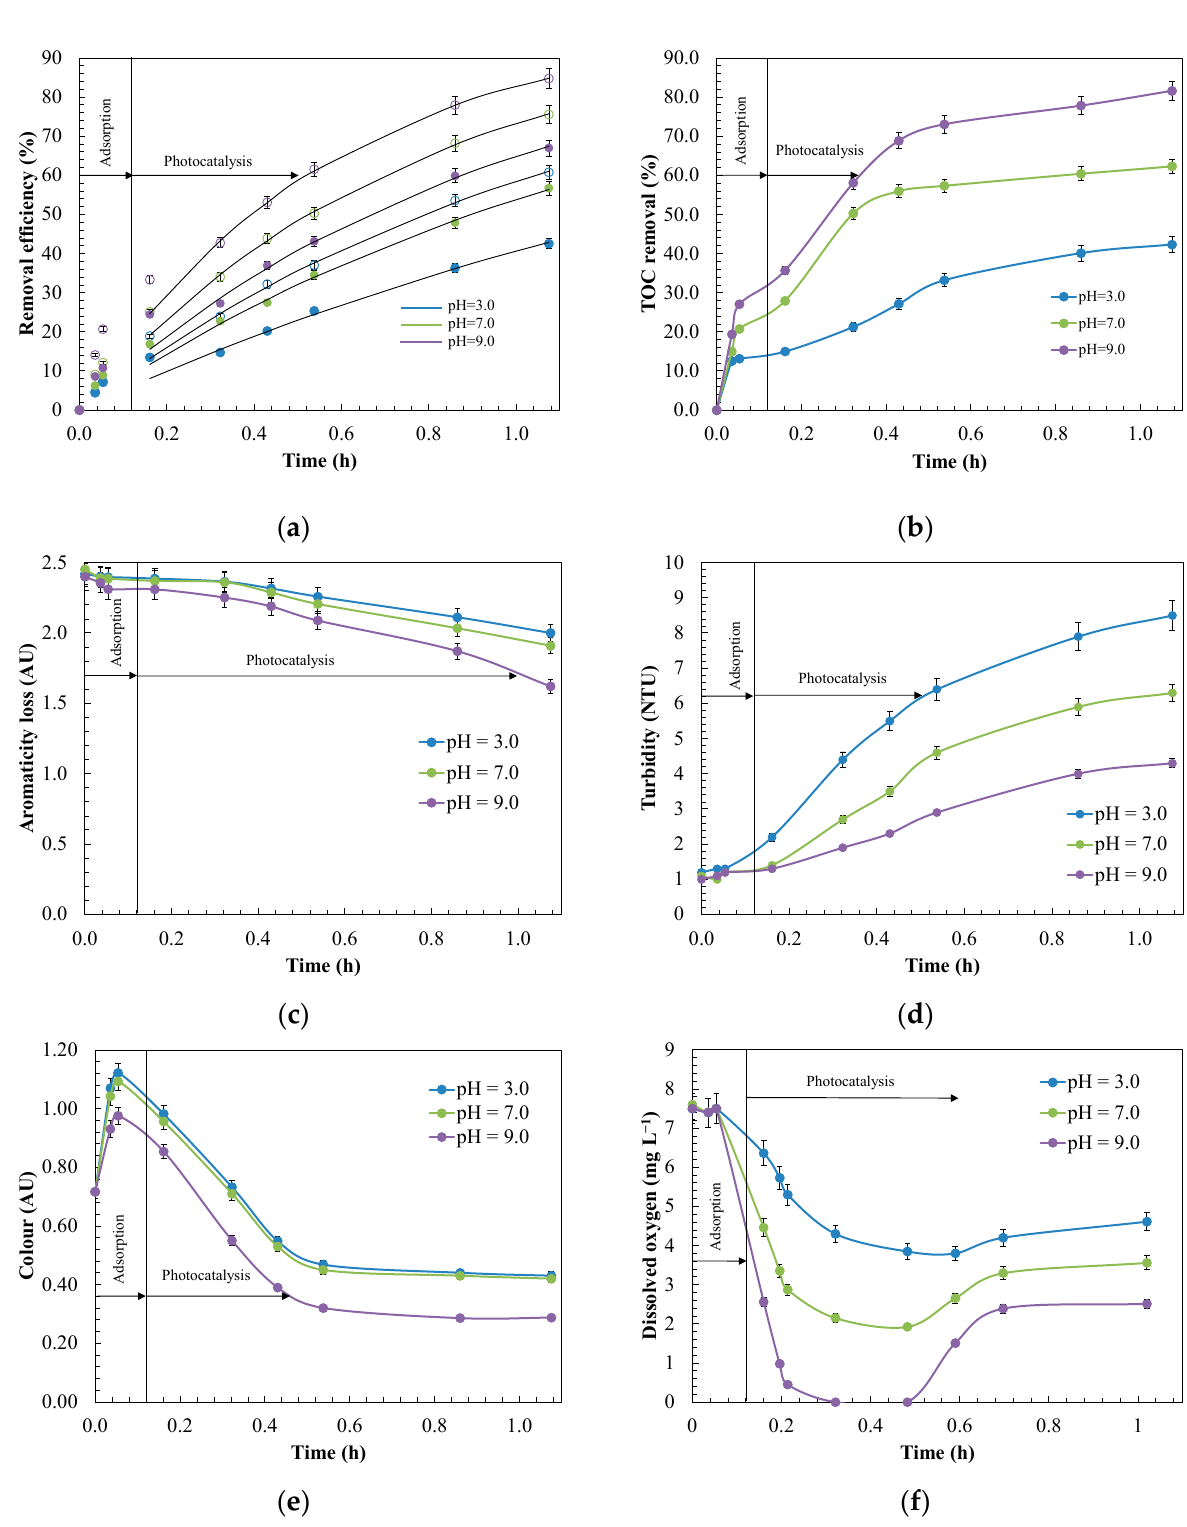
Figure 12. Study of the pH effect on the photocatalytic removal of ANI and BTH from industrial effluents with the MnO 2 /GAC-3 photocatalyst. Evolution of the: ( a ) primary degradation of ANI ( ○ ) and BTH ( ● ) fitted to the apparent first- order kinetic model; ( b ) total organic carbon (TOC) removal; ( c ) loss of aromaticity; ( d ) turbidity; ( e ) colour induction during aniline and benzothiazole oxidation; ( f ) dissolved oxygen. Experimental conditions: C 0 = 12.0 mg L − 1 ; m CAT = 0.9 g L − 1 ; Irradiation dose = 155.8 W m − 2 ; T = 26 °C.